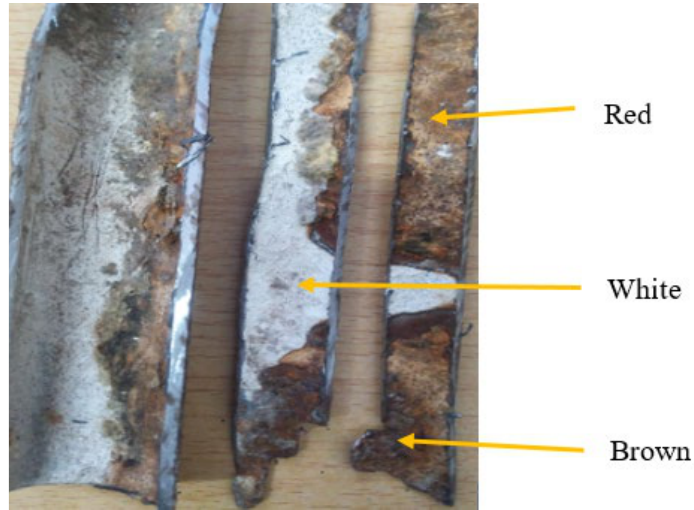
Figure 12. Photographs of the typical corroded pipe surface.